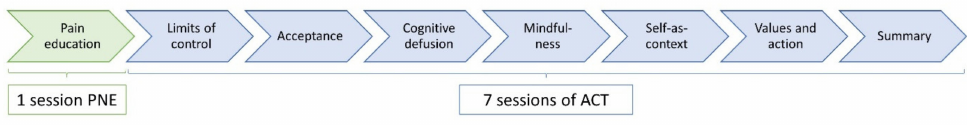
Figure 1. Overview of the Acceptance and Commitment Therapy Program, consisting of 1 session of Pain Neuroscience Education and 7 sessions of Acceptance and Commitment Therapy.